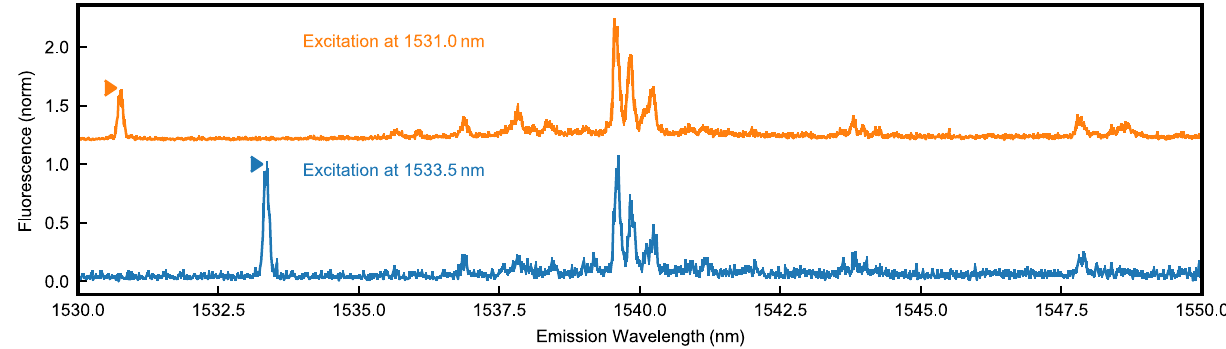
FIG. 13. Fluorescence upon off-resonant excitation in the CVD sample. The samples are excited at two different wavelengths (triangles): 1531.0 nm (orange, with added offset) and 1533.5 nm (blue), which do not coincide with one of the resonances in Fig. 2(a). The filtered fluorescence signal recorded after the laser pulses shows a peak at the excitation frequency and, in addition, some off- resonant fluorescence at several discrete wavelengths, which we attribute to charge relaxation via an optically active site